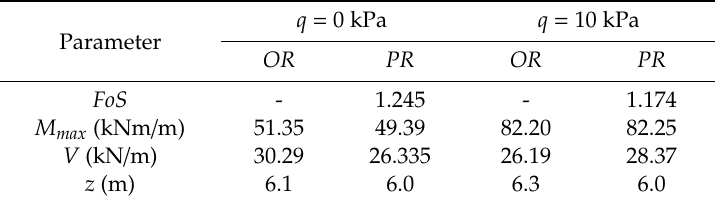
Table 7. Comparison of optimization results and numerical analysis for 5 m excavation